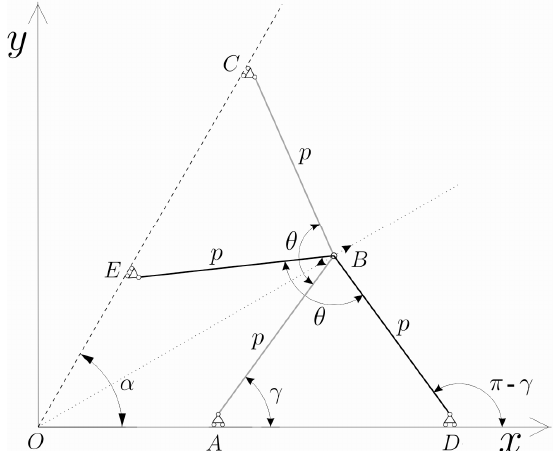
Figure 1: Pair of linkages movable with a single degree of freedom. The two rigid linkages ABC and EBD are shown in grey and black, respectively. They are constraint at the “coupler” point B to have the same displacement components. Points A and D and E and C can only move along straight